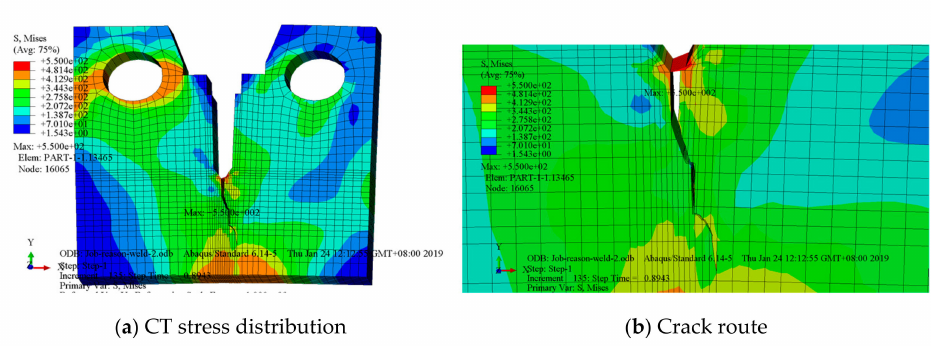
Figure 18. XFEM result of the weld metal. ( a ) CT stress distribution; ( b ) Crack route.